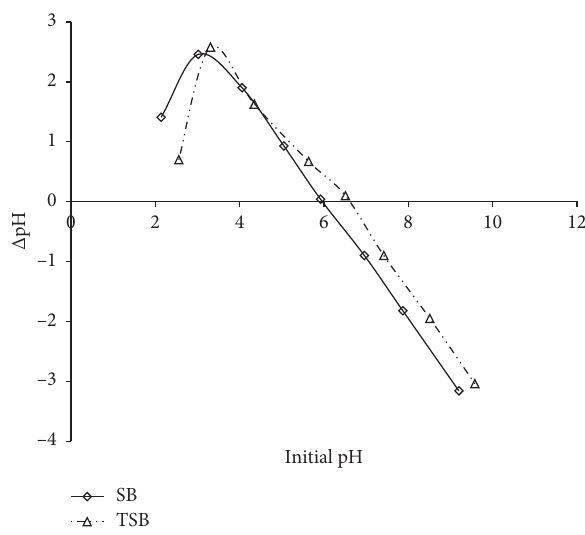
Figure 3: pH pzc determination of SB and